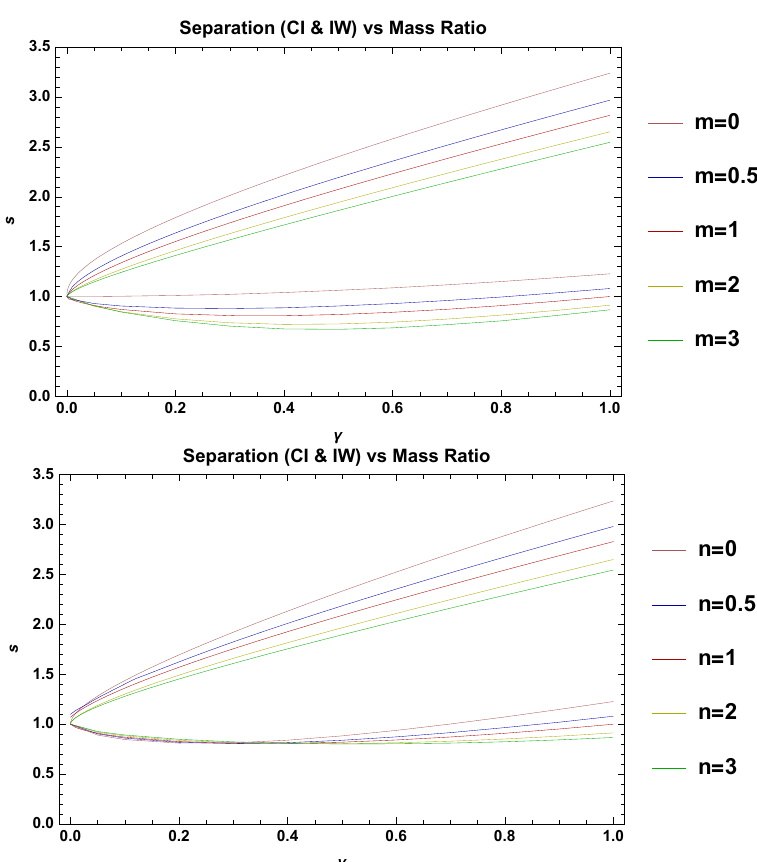
Figure 17. Critical values of the separation for the intermediate-wide transition s IW as a function of γ (upper curves); critical values of the separation for the close-intermediate transition s CI as a function of γ (lower curves). The upper panel is for n = 1 and variable m ; the lower panel is for m = 1 and variable n